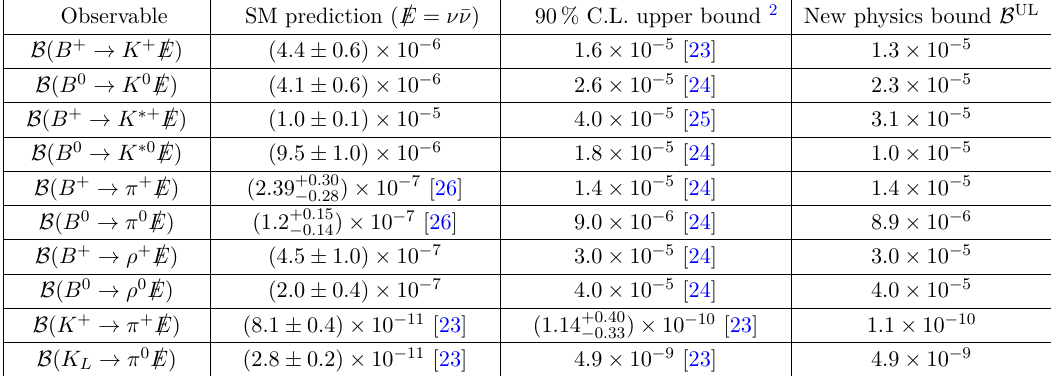
Table 2 . Summary on the status of FCNC B → ( K, K ∗ , π, ρ ) /E and K → π /E decays with missing